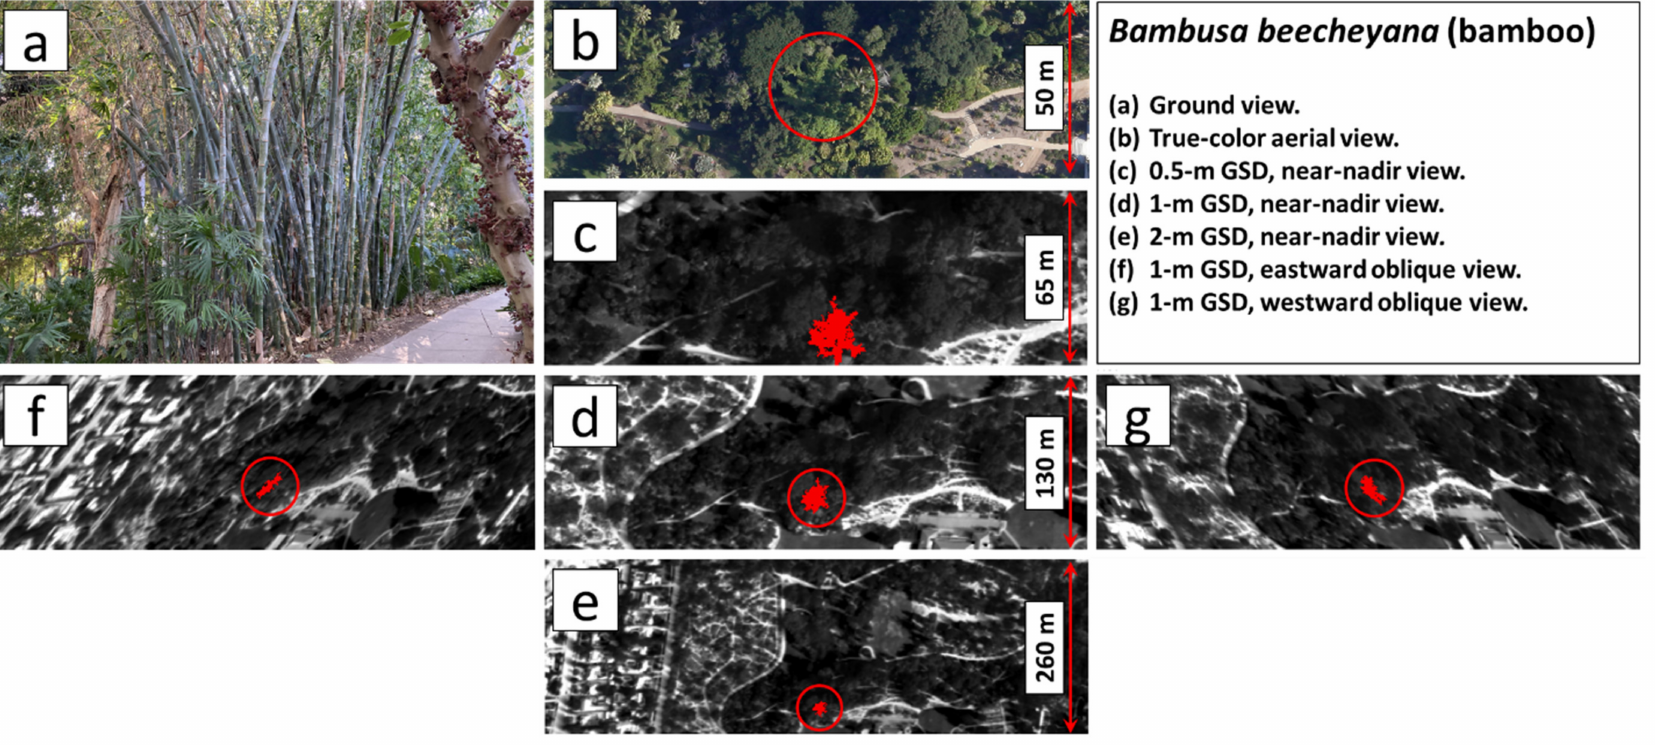
Figure 6. Bambusa beecheyana ID as a function of GSD and observation angle: ( a ) ground view of target stand, ( b ) true-color aerial image, ( c ) thermal scene image at 0.5-m GSD with target ROI overlay (red), ( d ) thermal scene image at 1-m GSD with target ROI overlay (red), ( e ) thermal scene image at 2-m GSD with target ROI overlay (red), ( f ) eastward-looking oblique thermal scene image at 1-m GSD with target ROI overlay (red), ( g ) westward-looking oblique thermal scene image at 1-m GSD with target ROI overlay